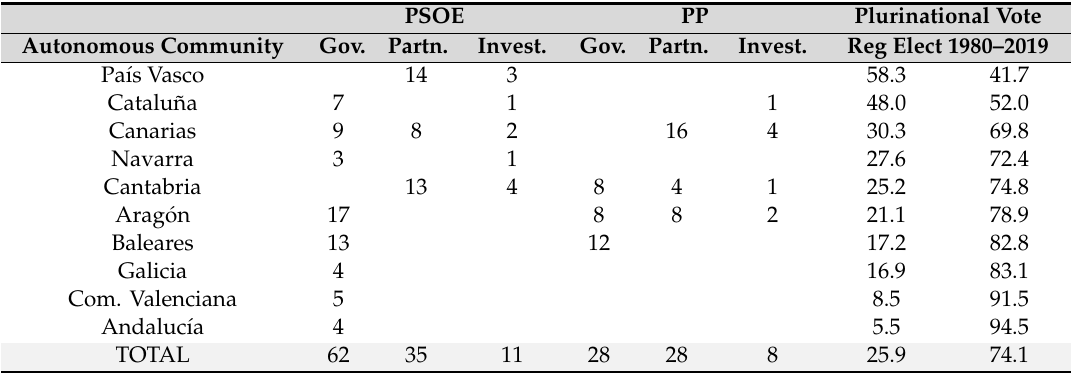
Table 2. Participation of Spanish state-wide parties in the plurinational governance of the Autonomous Communities,